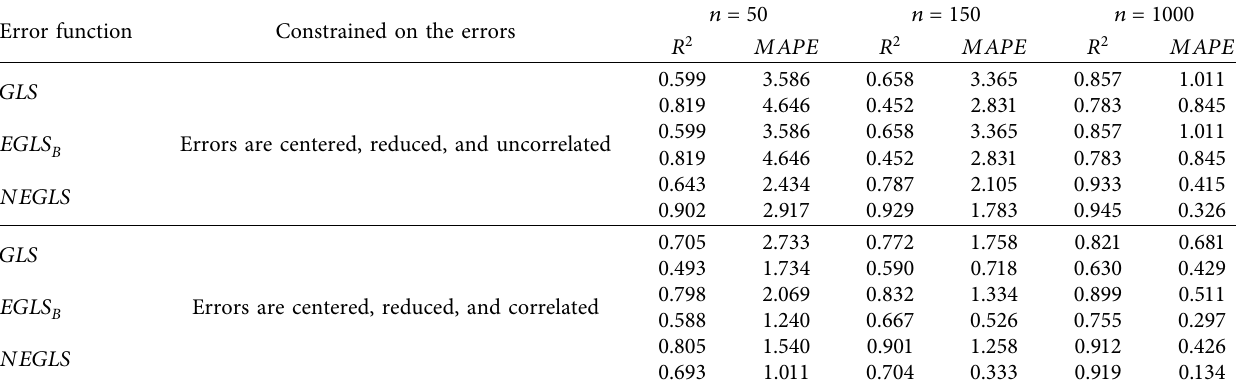
Table 1: Comparison of statistical performances.